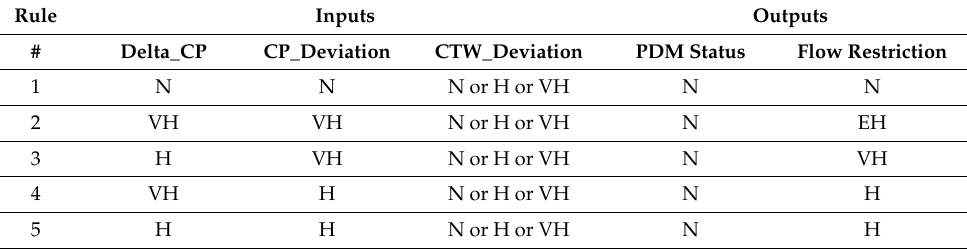
Table 6. FIS Rules